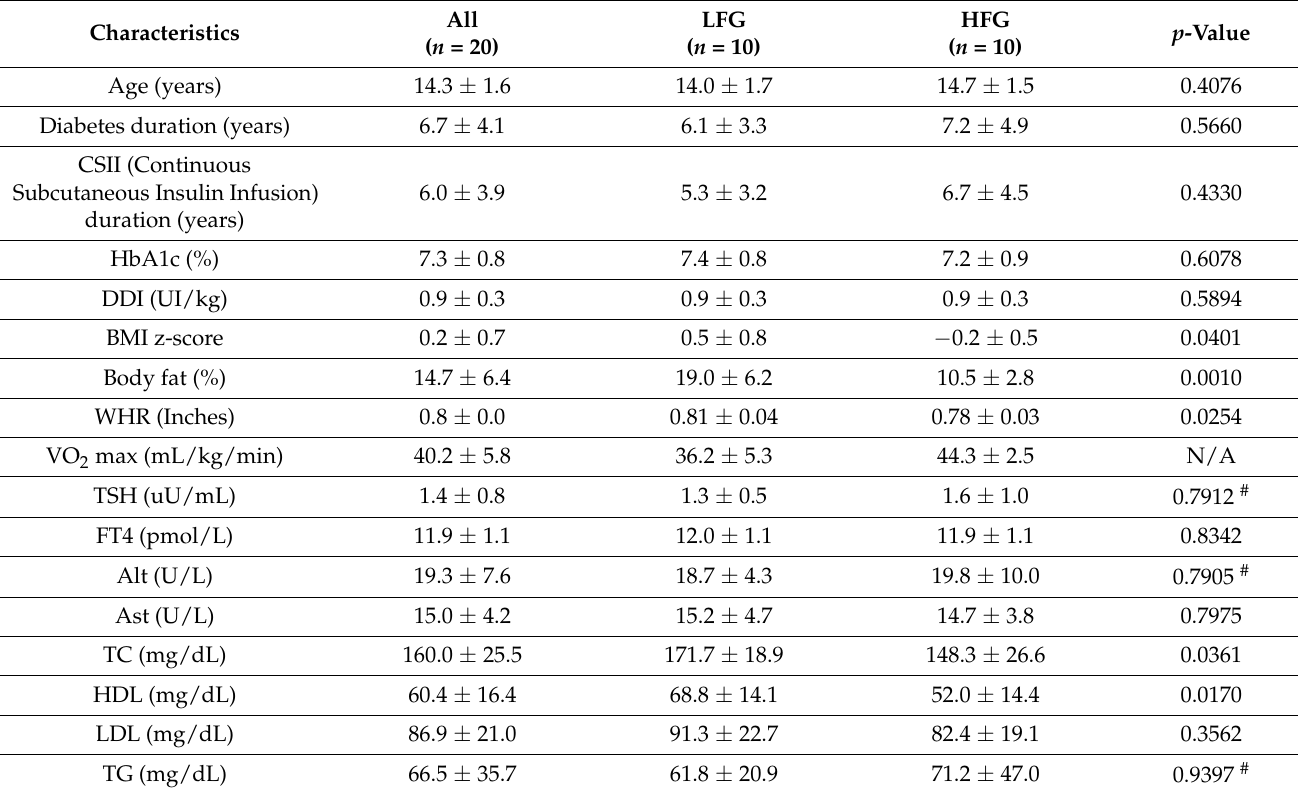
Table 1. Characteristics of the study group (All) and subgroups with lower (LFG) and higher (HFG) VO 2 max.